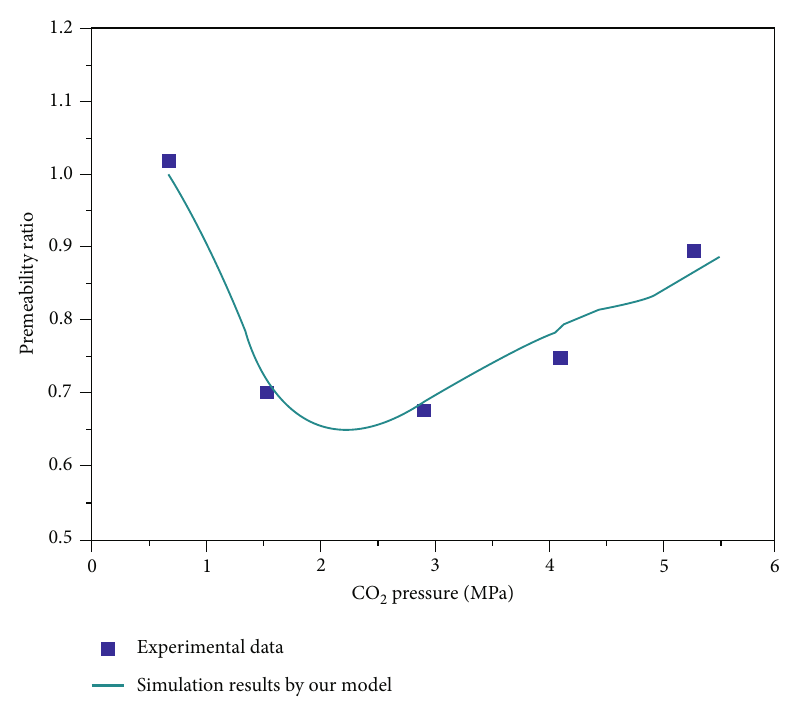
Figure 7: Results of coal permeability obtained by the experiment and simulation during CO